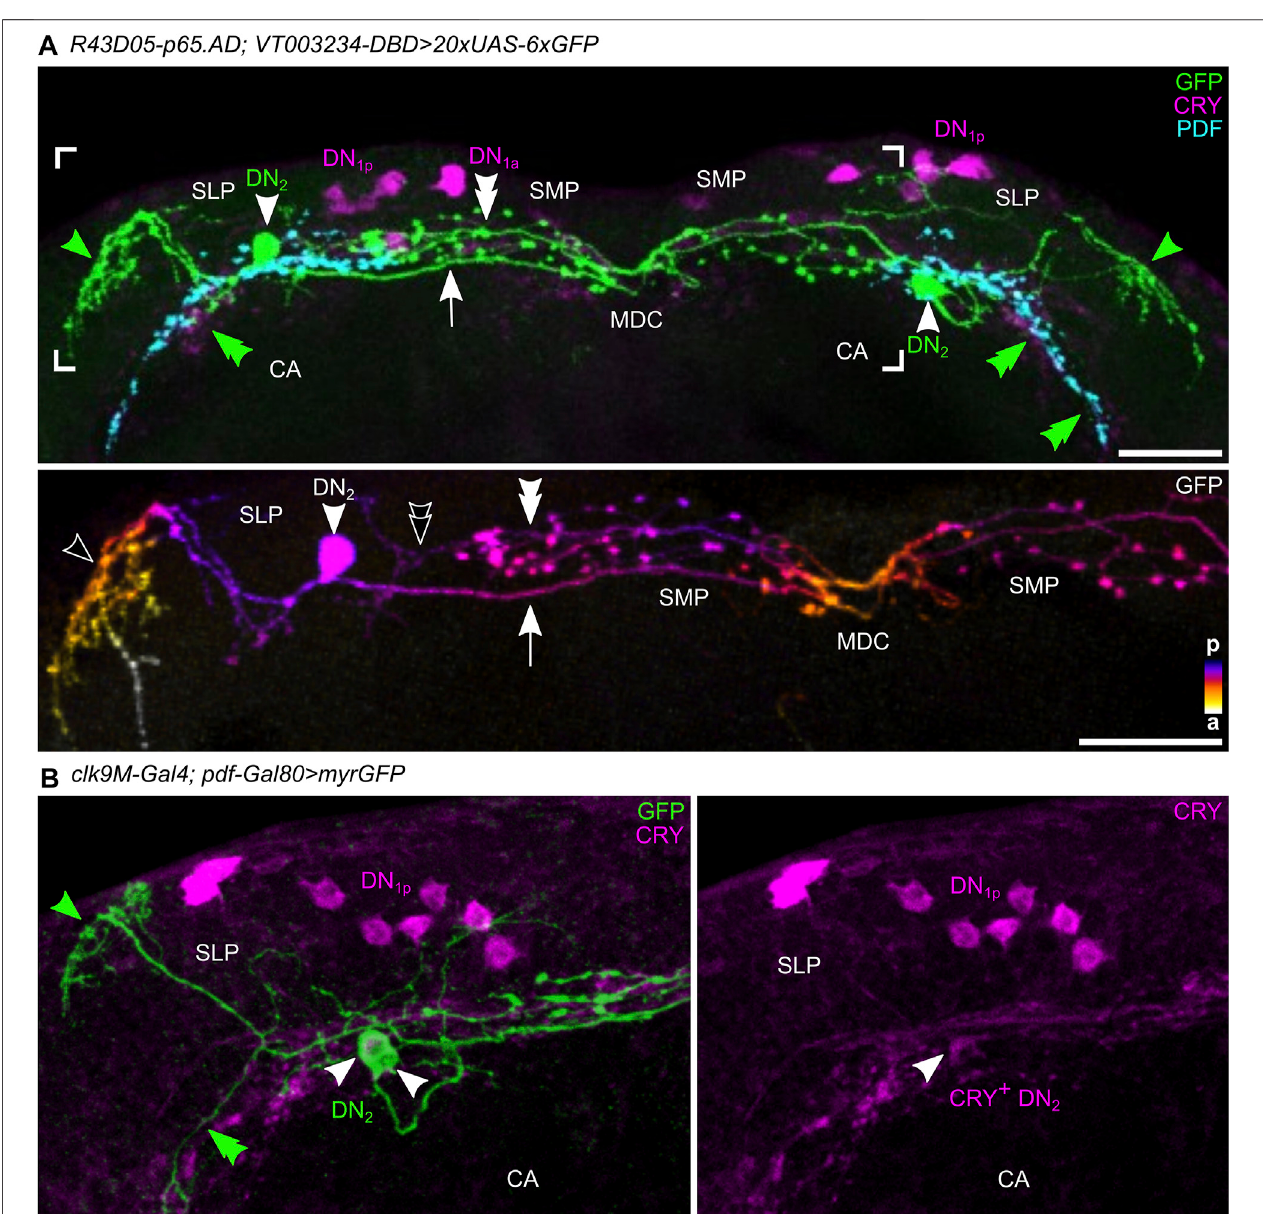
FIGURE9| regions.Interestinglytheydonotseemtoreceivesynapticinputfromtheclocknetwork. (C) DistributionoftheinputandoutputsynapsesoftheCRY-positive DN 1p samong the brain regions. The neurons form most oftheir synapses inthe SMP, AOTU, and SLP withmost synapses in the latter. The number ofinputand output synapses are similar in the different brain regions, but the two DN 1p s slightly differ in the percentage of output synapses in the SMP and AOTU. DN 1p #5813071319 has more inputandoutputintheSMPandlessinputandoutputintheAOTUthanDN